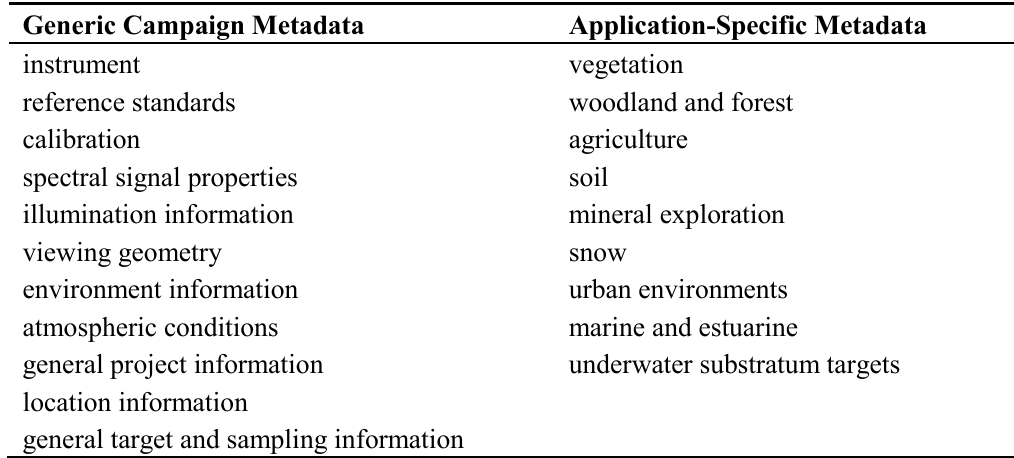
Table 1. Categories of metadata fields in the